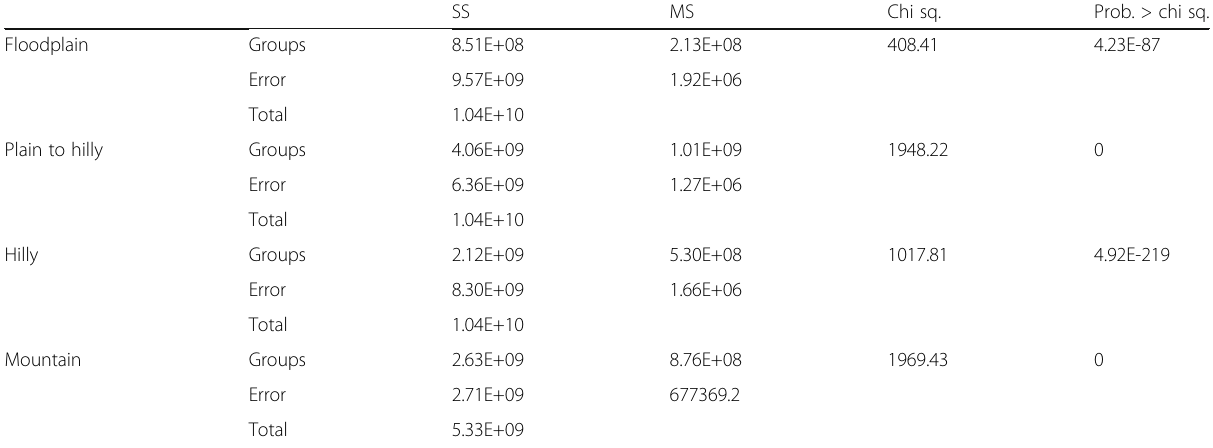
Table 6 Kruskal-Wallis significance tests of Spc in each study area based on different land covers SS MS Chi sq. Prob. > chi